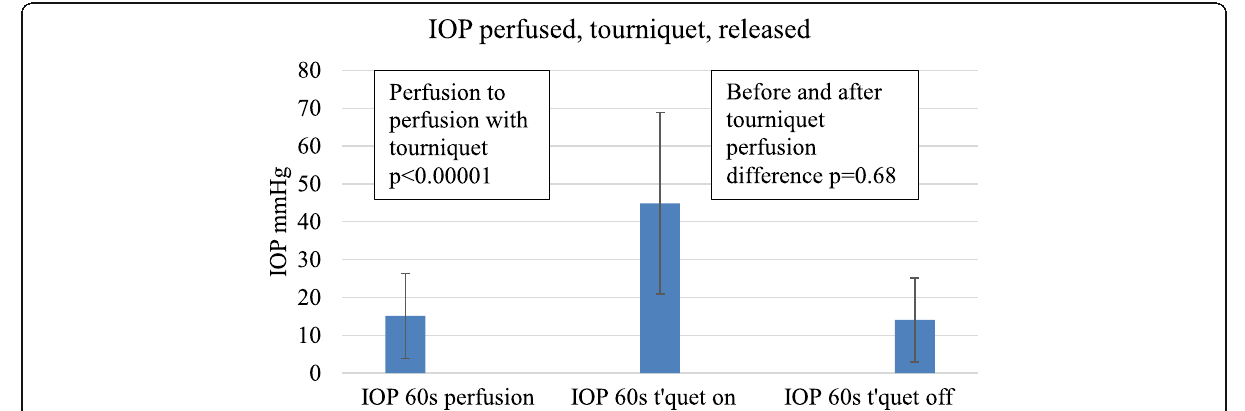
Fig. 3 Additional rise in IOP with a proximal tourniquet for 60 s and effect of removal of the tourniquet after a further 60 s with continued perfusion of serum at 150 cms pressure, error bars